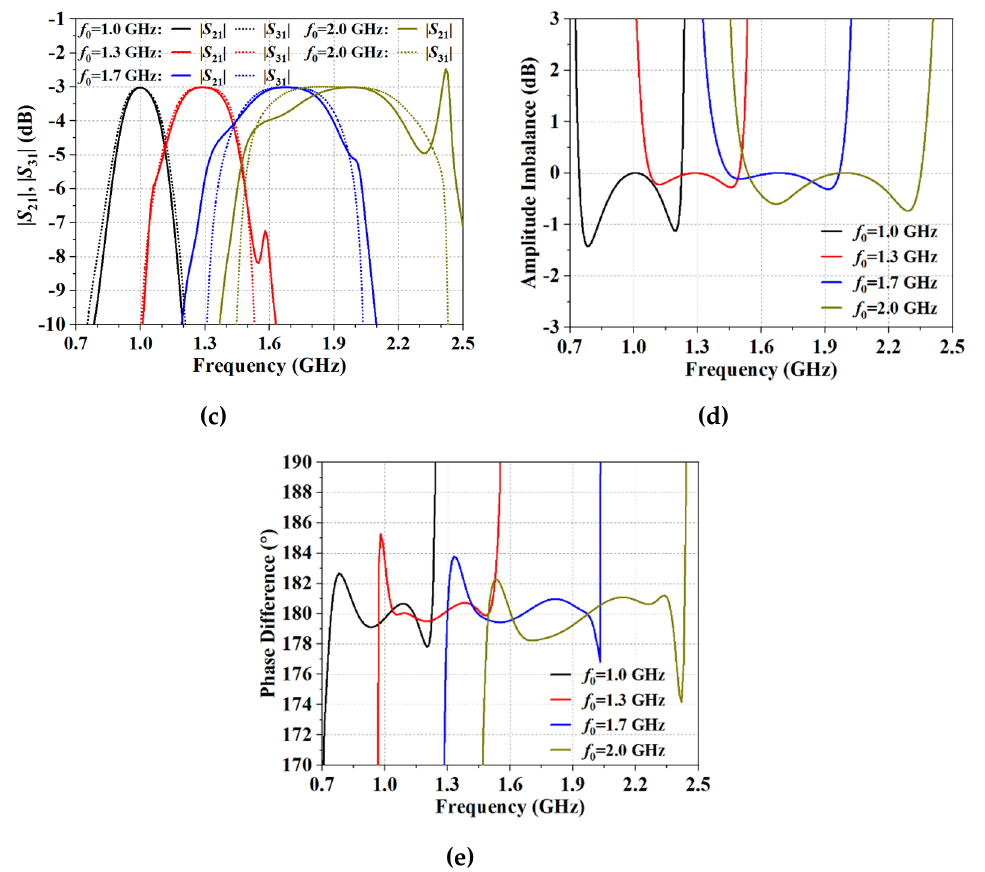
Figure 9. Simulated results at 1.0, 1.3, 1.7, and 2.0 GHz. ( a ) | S 11 | and | S 23 |; ( b ) | S 22 | and | S 33 |; ( c ) | S 21 | and | S 31 |; ( d ) Amplitude imbalance; ( e ) Phase difference. Table 1. Capacitance of the varactors for different frequencies.